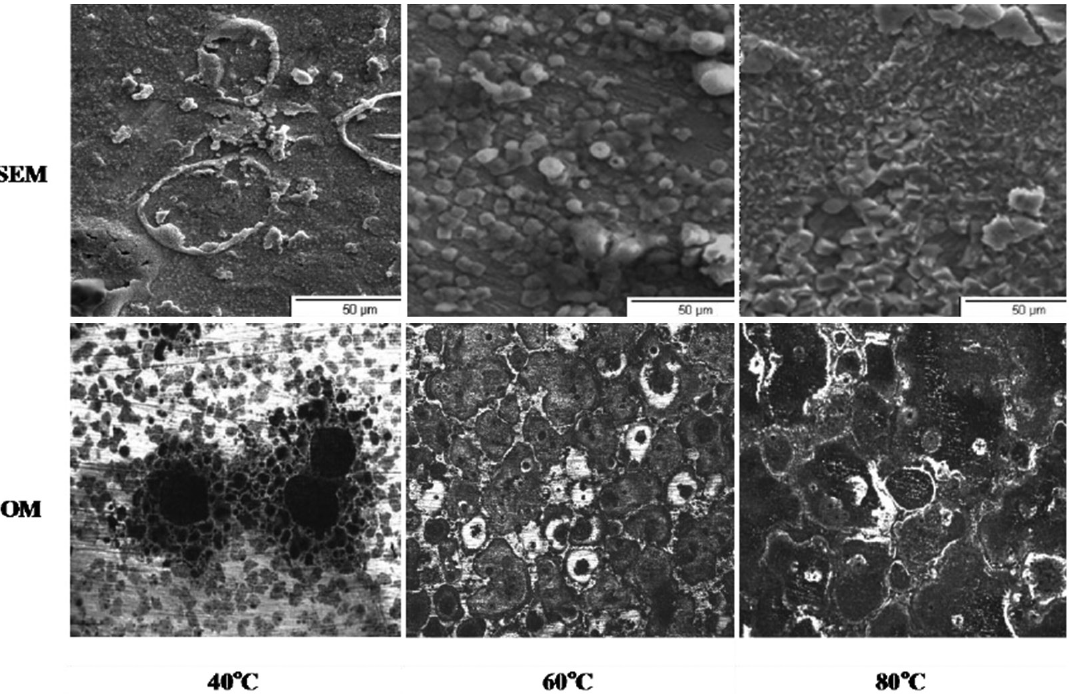
Figure 11. Samples observed after exposure to the vapor phase; SEM micrographs before removal of the corrosion products, and OM micrographs (at 50X) after subsequent removal of the resulting surface